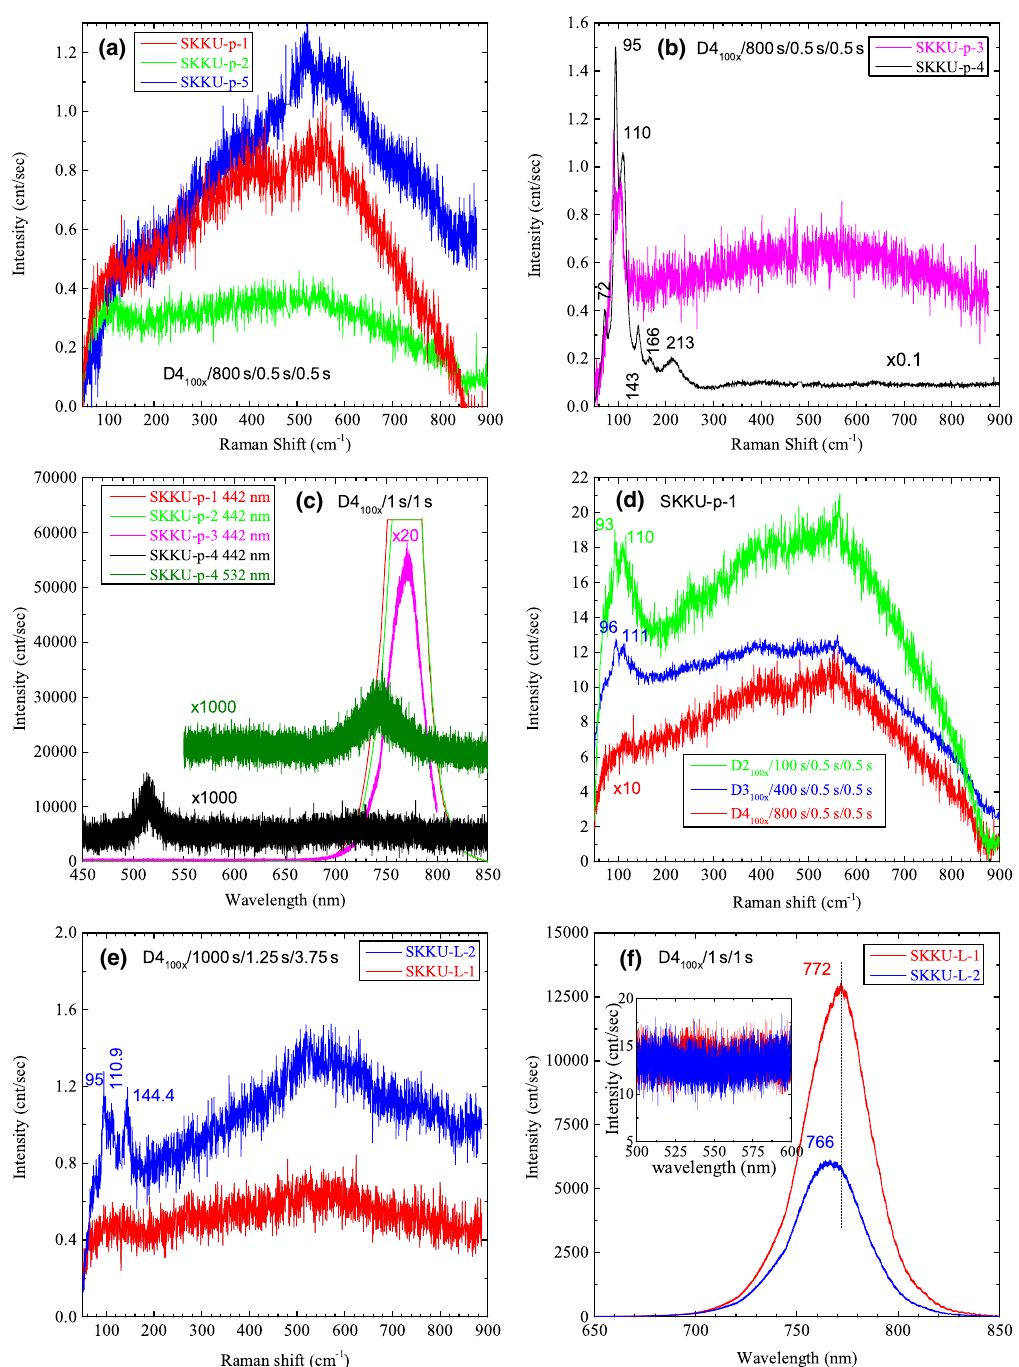
FIG. 2. Raman and PL spectra of SKKU samples at different stages of structure transformation. (a),(b) Representative Raman spectra at different stages of structure transformation from MaPbI 3 to PbI 2 , measured under a very low excitation density D4 (SKKU-p-3 was measured with the 50 × L lens, but multiplied by the laser density ratio between the 100 × and 50 × L lens). (c) PL spectra measured at D4 from the same location as in (a) and (b) before the Raman measurement. (d) Raman excitation density dependence of the most pristine sample SKKU-p-1. (e) Low-excitation density (D4) Raman spectra for two large-domain SKKU-L samples. (f) The corresponding PL spectra of (e), measured under D4 before the Raman measurement. The inset shows the spectral region near the PbI 2 band